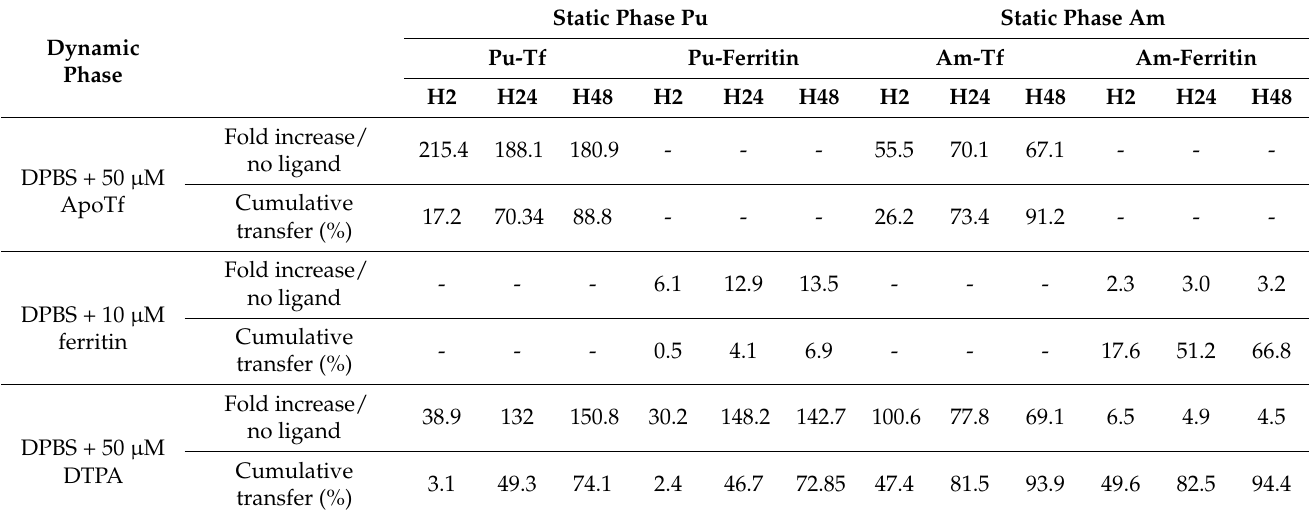
Table 4. Transfer enhancement of Pu/Am-protein complexes in the presence of ligands in the dynamic phase. Ratio of medians of transferred activity and cumulative transfer in the dynamic phase (%/initial activity) for protein-actinide complexes in the presence of ligands in the dynamic phase vs. in the absence of ligand. Values are from two experiments performed in